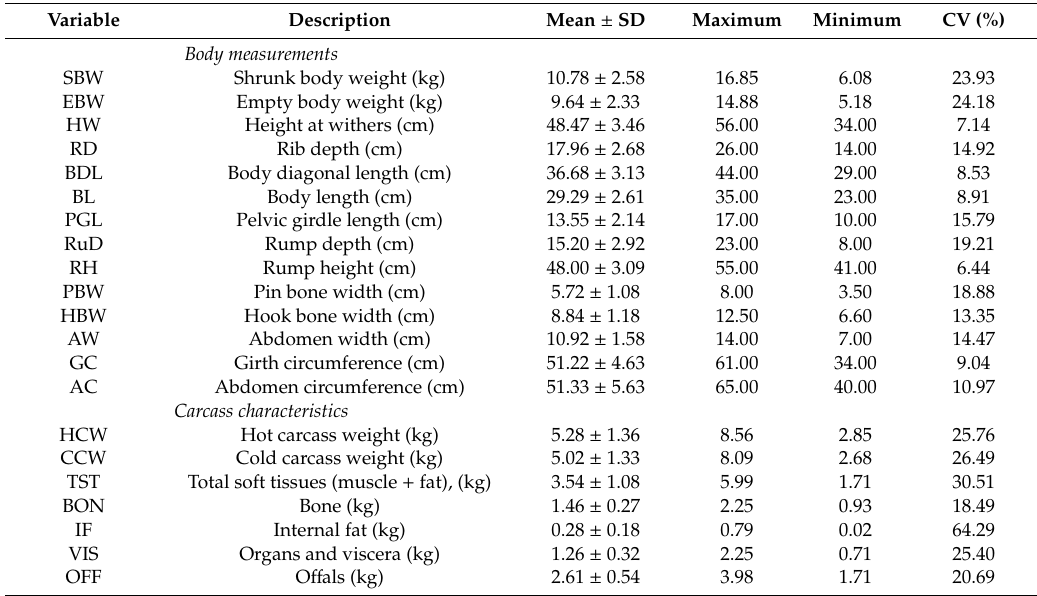
Table 1. Descriptive analyses of the body measurements of live animals (n = 66 suckling lambs).